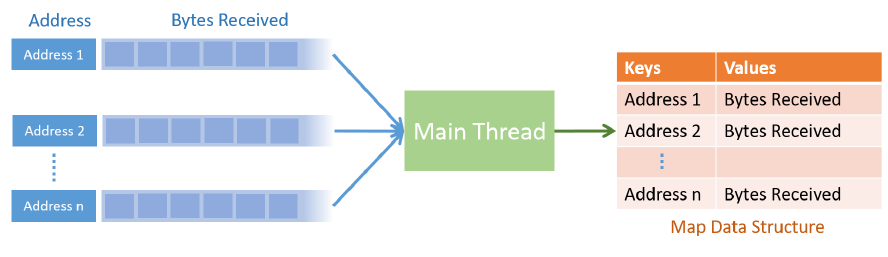
Figure 9. Main thread operation on received bytes.